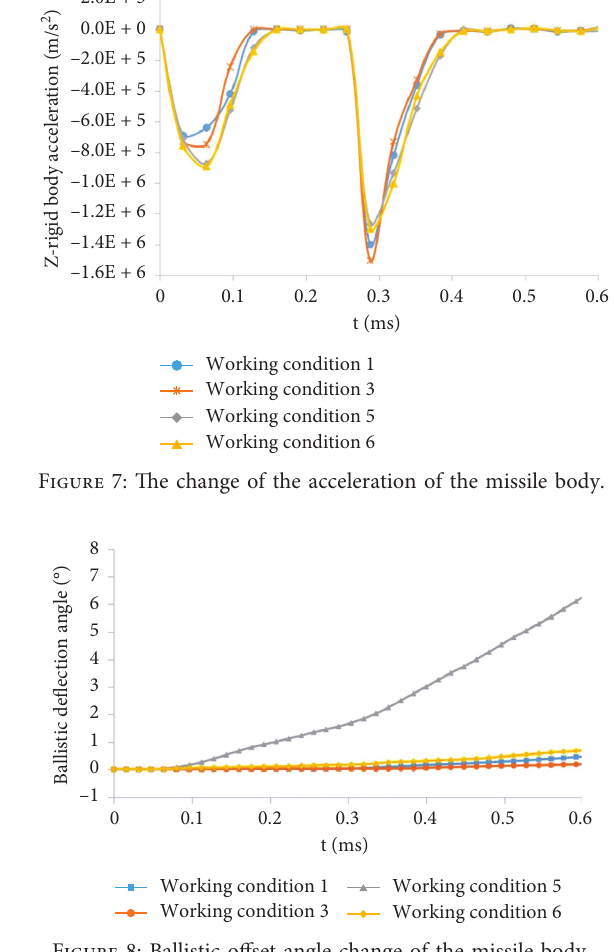
Figure 11: Ballistic offset angle changes over time when the speed changes.